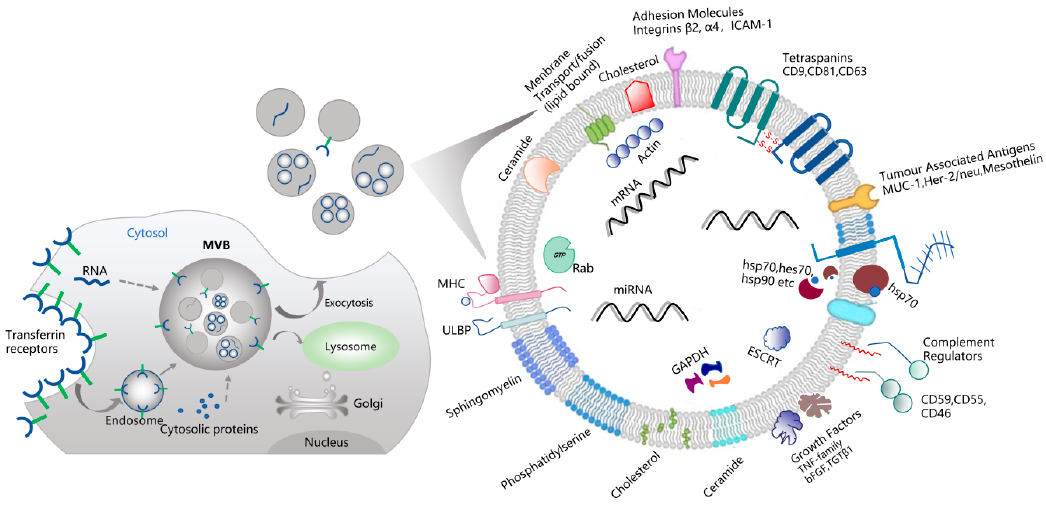
Figure 1. Exosomes biological features. Exosomes are vesicles of endocytic origin. After the plasma membrane sprouts inward to form the early endosomes, the multivesicular bodies (MVBs) further sprouts inward to produce intraluminal vesicles (ILVs), MVBs fuse with the plasma membrane, releasing exosomes into the extracellular space. Exosomes are mainly consisted by proteins, lipids and nucleic acids. Nucleic acids include microRNA (miRNA), transfer RNA (tRNA), ribosomalRNA (rRNA), messenger RNA (mRNA), and non-coding RNA (ncRNA). Exosomes also contain endosome-specific tetraspanins (CD9, CD63, CD81) on their membrane surfaces. major histocompatibility complex, MHC; UL16 binding protein, ULBP; hot shock protein, hsp; ras-related gtp-binding protein, Rab; endosomal sorting complex required for the transport, ESCRT.